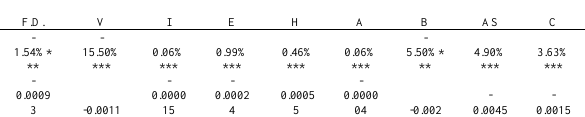
Table 2. Determinants of choosing full-service grocery stores Notes: Logit regression results for the prob. of choosing a full- service grocery store, N = 1,107,754. First row: Marginal probability. Second row: Delta-method standard errors. ***